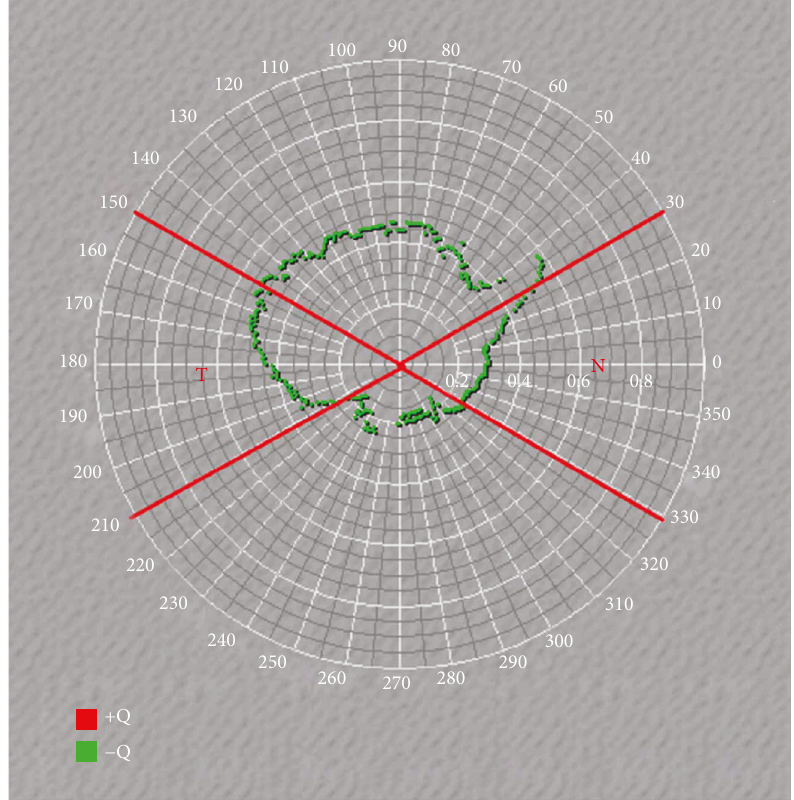
Figure 1: An example of the Q value distribution of the right eye; we selected the nasal cornea (330 ° – 29 ° ) and the temporal cornea (150 ° – 209 ° ) in our